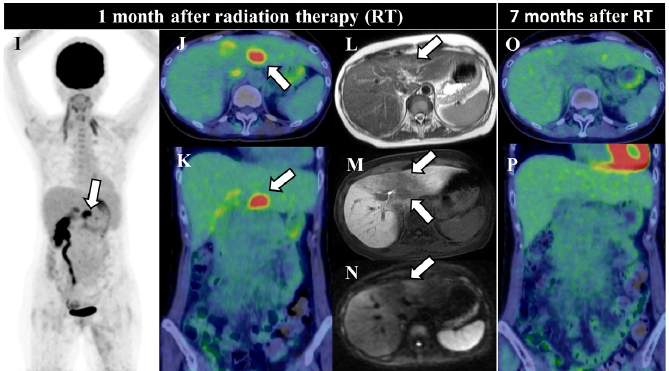
Figure 1. A 44-year-old woman with abdominal diffuse large B-cell lymphoma (DLBCL) received six courses of rituximab, cyclophosphamide, doxorubicin, vincristine, and prednisone. Treatment assessment 2-Deoxy-2-[ 18 F]fluoroglucose ([ 18 F]FDG) positron emission tomography/computed tomography (PET/CT) showed high [ 18 F]FDG uptake scattered over a large mass in the abdomen ( A – F arrows). She received additional radiotherapy (RT) with 45 Gy in 25 fractions with three-dimen-